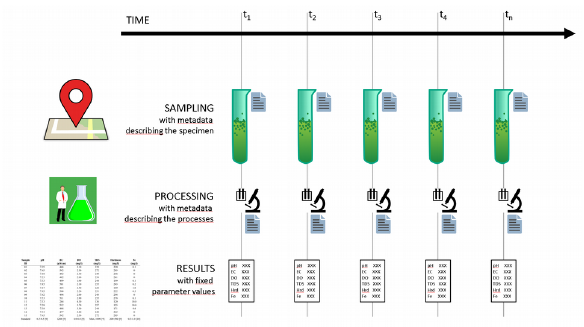
Figure 3 . The Specimen observation type.